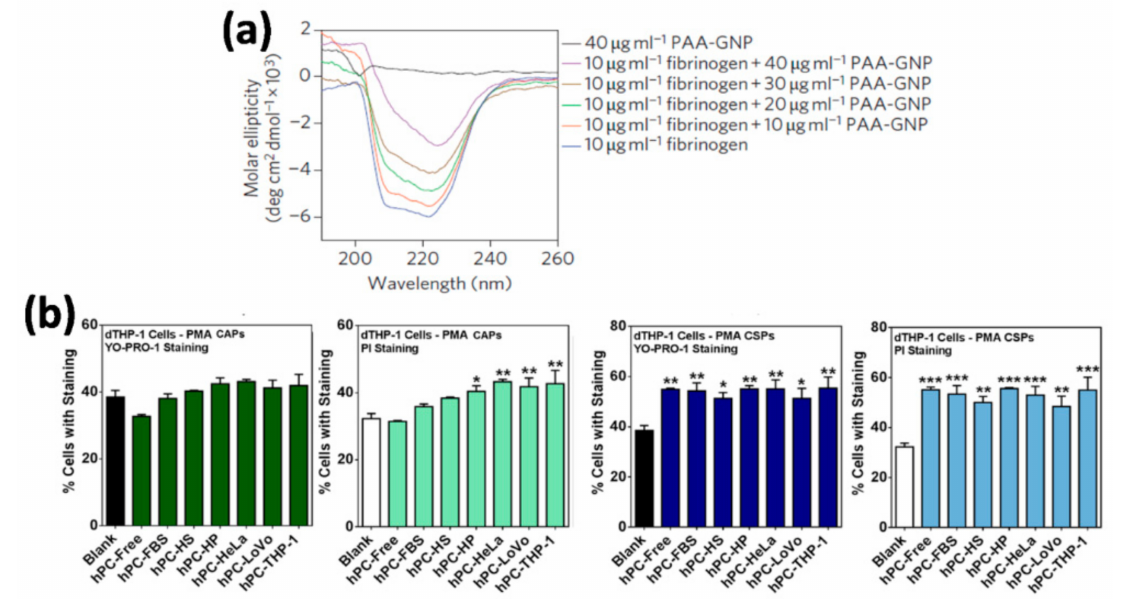
Figure 3. ( a ) Protein denaturalization on the surface of NPs. Secondary structure of the fibrinogen protein measured by circular dichroism after being incubated with di ff erent concentrations of 5-nm poly(acrylic acid)-coated gold nanoparticles (PAA–GNPs).Figure from [94]. ( b ) E ff ect of protein corona formation and composition on early apoptosis and cell death responses in THP-1 cells, a human Leukemic monocytes cell line. Poly (metacrylic acid) hollow particles (PMA CAPs) (in green) and PMA cores-shell particles (PMA CSPs) (in blue) were exposed to various environments (di ff erent media, serum free control, fetal bovine serum (FBS), human serum (HS), human plasma (HP), and culture media with three di ff erent cell lines HeLa, LoVo, and THP-1) to acquire a hard protein corona (hPC). The early apoptosis (YO-PRO-1 staining) and cell death (PI staining) were measured by flow cytometry. Data are shown as the mean ± standard error of at least four independent experiments, with at least 10,000 cells analyzed in each experiment. * p < 0.05, ** p < 0.01, *** p < 0.001, versus the column of “Blank” (indicating untreated cells) (one-way ANOVA Dunnett’s multiple comparison test). Figure from